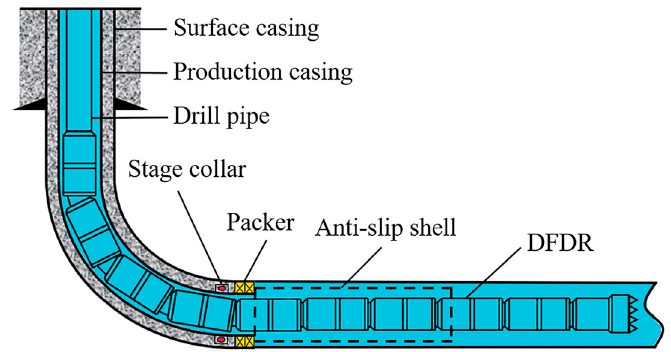
Figure 14. Schematic of downhole pipe structure of DFDR-based URHW drilling.